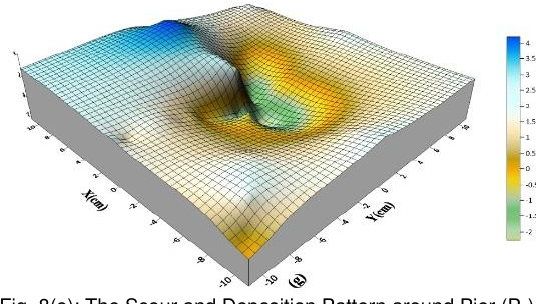
Fig. 8(k): The Scour and Deposition Pattern around Pier (P 2 ) at angle 15 0 and flowrate 14L/Sec.